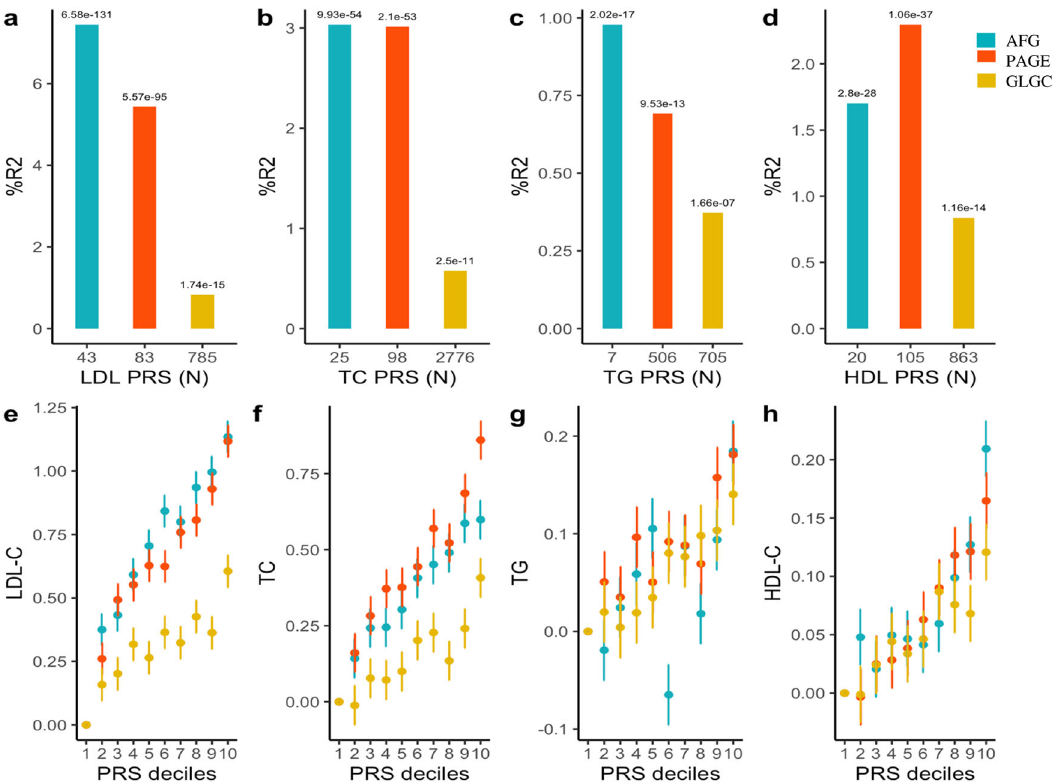
Fig. 5 Transferability of Polygenic Risk Score (PRS) Models derived from a sub-Saharan African, an European and a Multi-ancestry GWAS to the AWI-Gen dataset. Plots showing additional variance explained (%R 2 ) by each PRS for ( a ) LDL-C, ( b ) TC, ( c ) TG and ( d ) HDL-C in the AWI-Gen validation dataset ( N = 7103). PRS based on sub-Saharan African discovery dataset (AFG, N = 13,115 individuals) 7 is shown in blue, European (GLGC, N = 188,577 individuals) 15 in yellow and Multi-ancestry (PAGE, N = 49,839 individuals) 36 in red. Number of SNPs in each PRS is shown below and P -values (two-tailed estimates using PRSice2) are shown over the bars. All the PRS were signi fi cant for all lipid traits indicating transferability. However, the sub-Saharan African and Multi-ancestry PRS models had higher predictive accuracy compared to the European model. PRS strati fi cation of ( e ) LDL-C, ( f ) TC, ( g ) TG and ( h ) HDL-C. Point range-plots comparing the difference in lipid-trait mean (mmol/L) of the upper PRS decile from the lowest, strati fi ed by the discovery datasets are shown. The error bars show mean ± 95% con fi dence intervals. Additional details in Supplementary Data